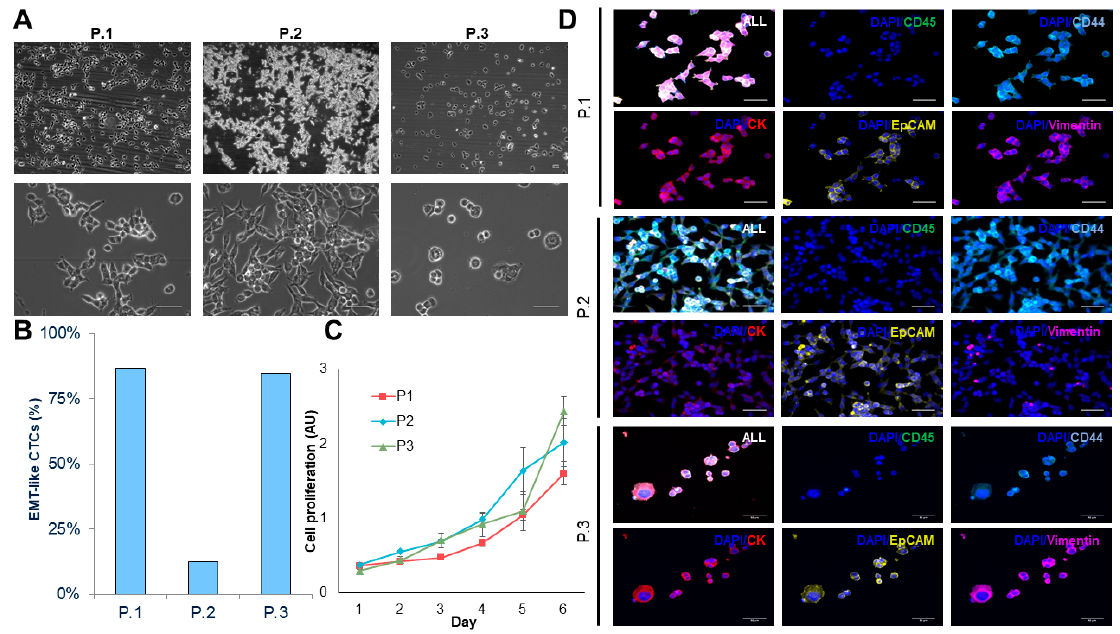
Figure 3. Characterizing CTC-derived cell lines. ( A ) Brightfield images (10 × and 40 × ) of expanded CTC cultures. ( B ) Percentage of epithelial-to-mesenchymal transition (EMT)-like CTC in adherent cultures. ( C ) Growth curve analysis of adhered CTC cultures (n = 3). ( D ) Representative images of immunofluorescence staining using cytokeratin (red) / vimentin (magenta) / CD44 (light blue) / CD45 (green) / DAPI (blue). (Scale bar = 50 µ m).